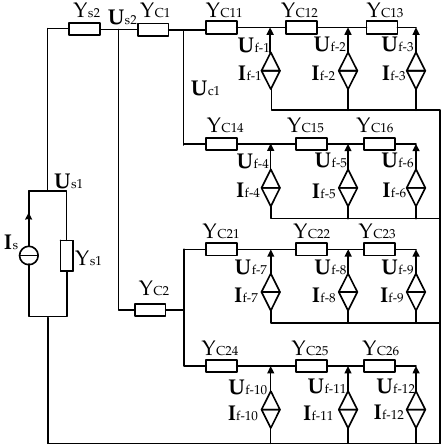
Figure 4. Equivalent fault analysis model of the tested power grid connected with PV generators.